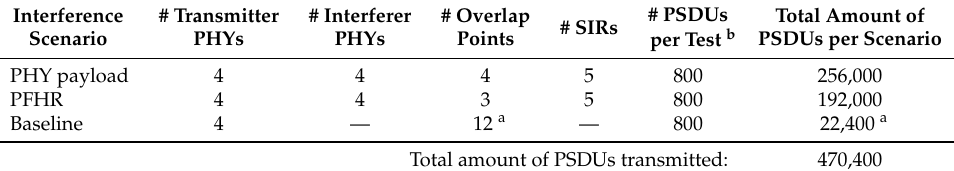
Table 4. Extent of our measurement